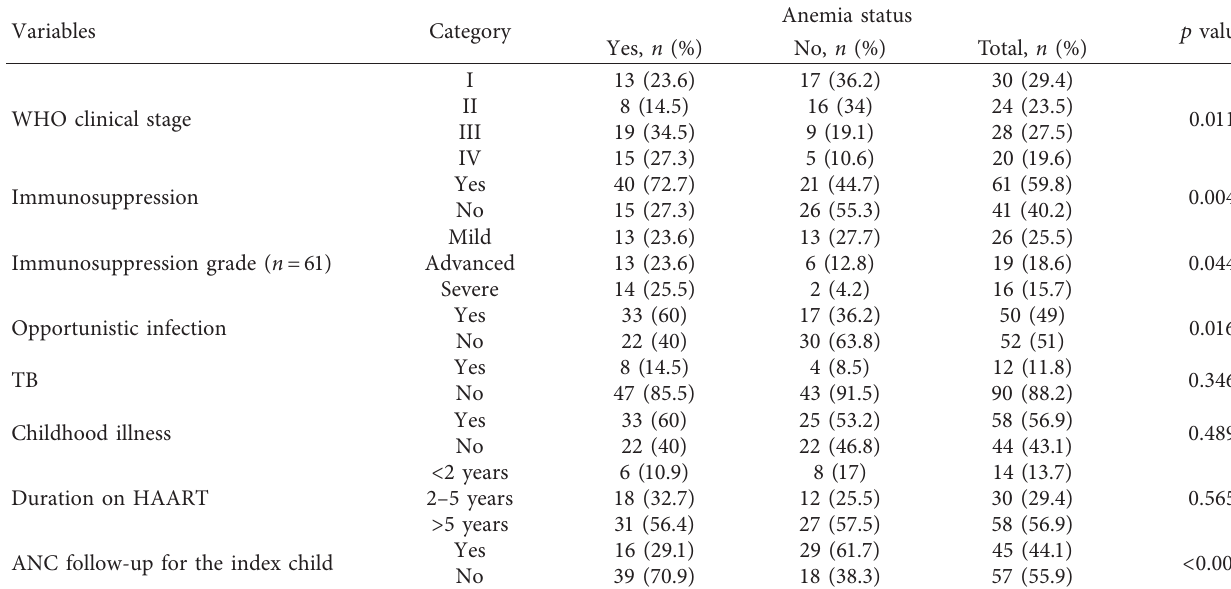
Table 3: Children’s HIV status by anemia status of HIV-infected children aged 6 months to 15 years, in the Afar region, Ethiopia, 2018.